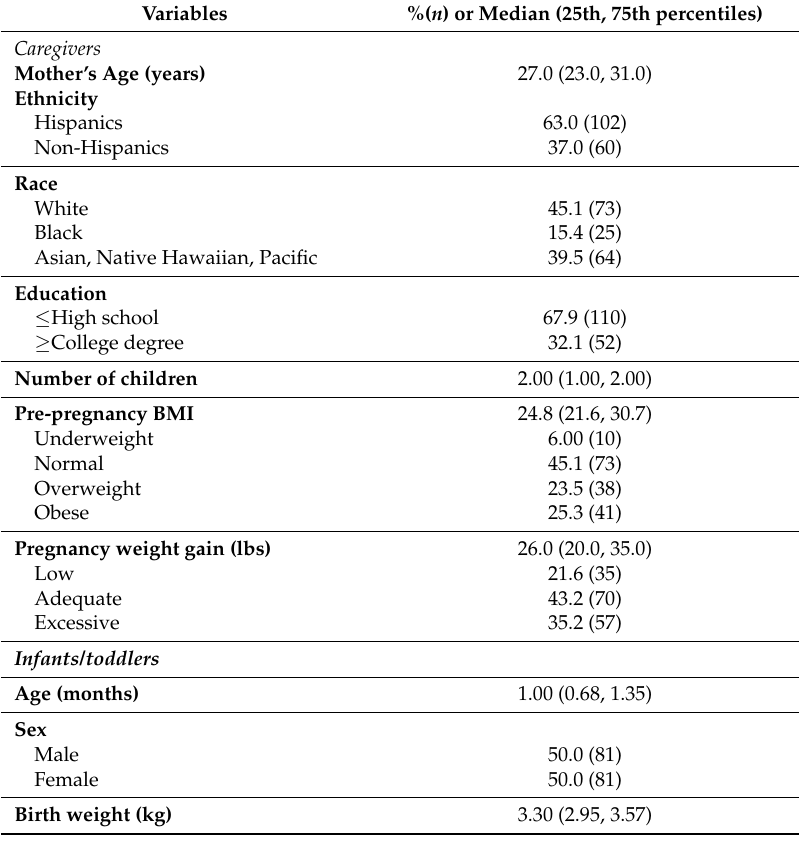
Table 1. General characteristics of caregivers and their infants at baseline ( N = 162).